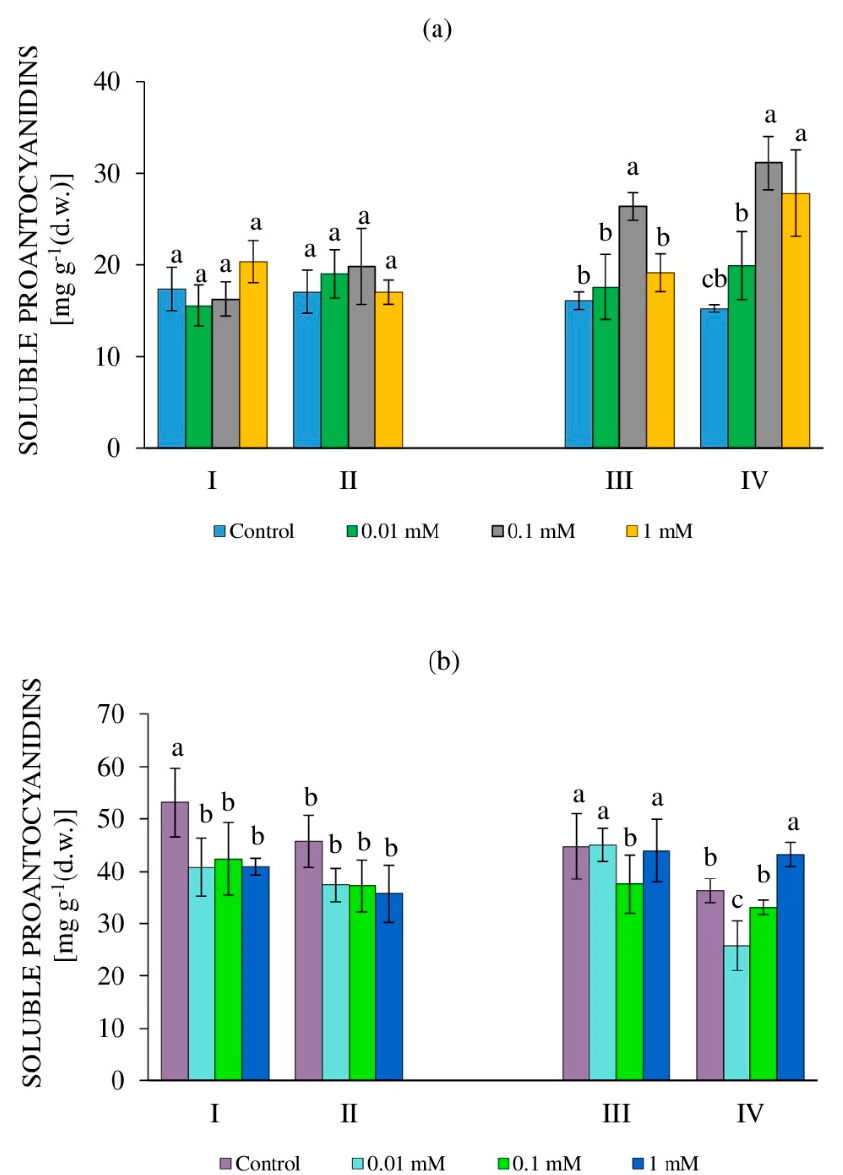
Figure 6. The content of soluble proanthocyanidins in callus cultures of tea plants at 24 days (I, II) and 36 days (III, IV) of age, grown in the dark ( a ) or in the light ( b ) and exposed to various concentrations of H 2 O 2 —0 (control), 0.01 mM, 0.1 mM, and 1 mM. Variants: I, III—rapid response of callus cells (2 h exposure to H 2 O 2 ); II, IV—delayed response of callus cells (48 h after exposure to H 2 O 2 ). Different letters indicate significant differences between exposure conditions ( p ≤ 0.05).